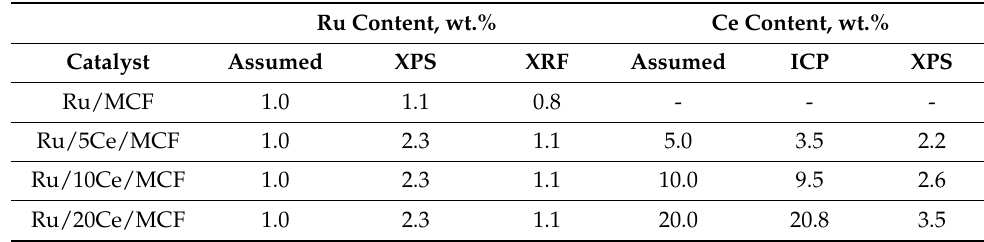
Table 2. Content of metals in the catalysts. Ru Content, wt.% Ce Content,